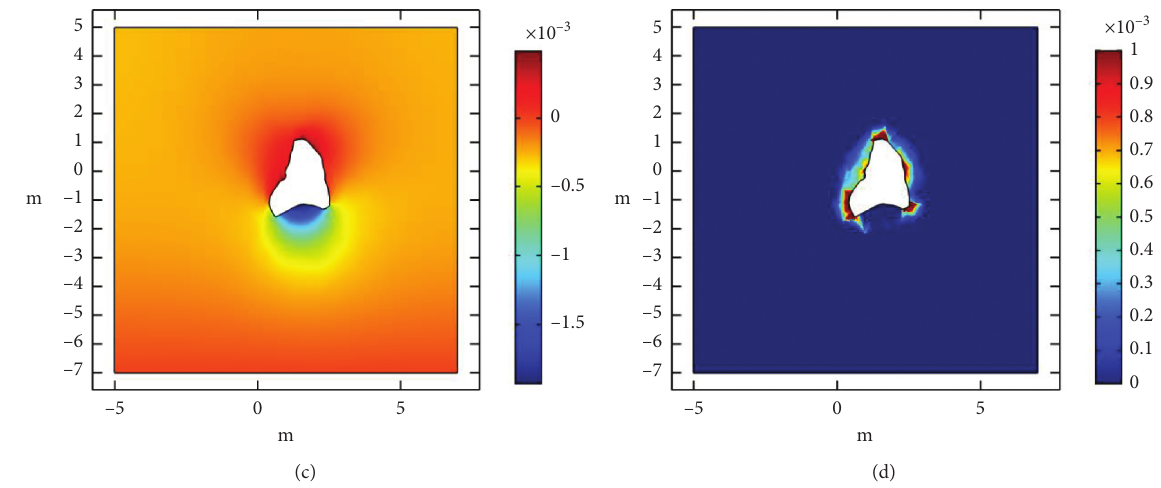
Figure 17: Displacement field and plastic zone of surrounding rock using irregular karst caves. (a) 2D displacement field using irregular cave I. (b) 2D plastic zone using irregular cave I. (c) 2D displacement field using irregular cave II. (d) 2D plastic zone using irregular cave